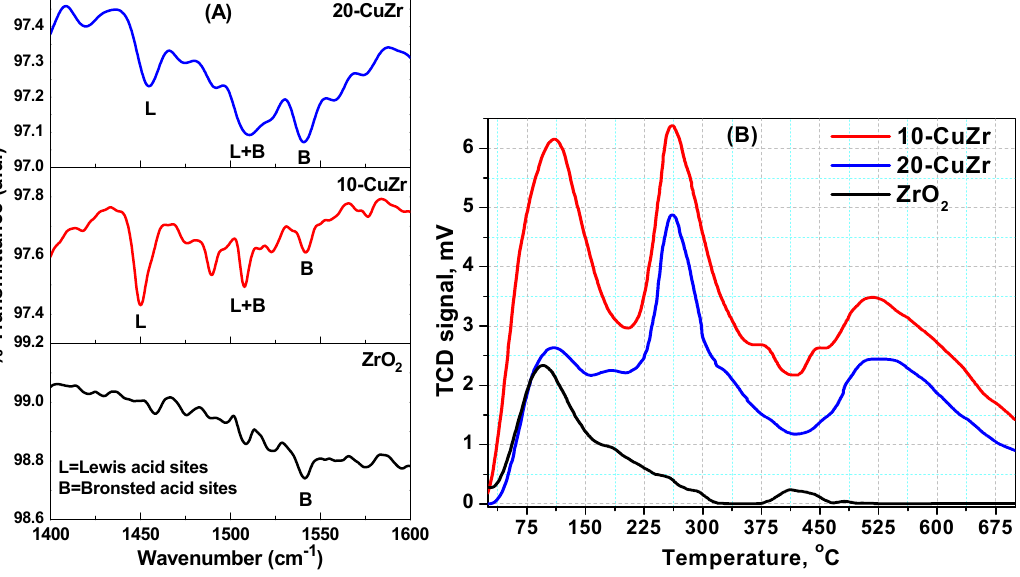
Figure 7. ( A ) FTIR spectra after pyridine adsorption ( B ) NH 3 ‐ TPD patterns for ZrO 2 and CuZr nanocomposite samples. Table 3. Results from FTIR analysis of pyridine adsorption and NH 3 -TPD